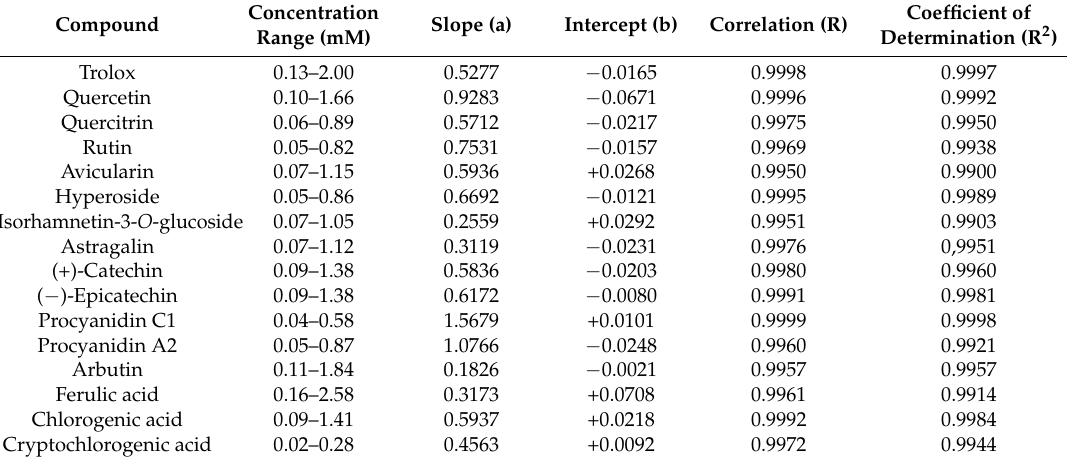
Table 4. Calibration curves (y = ax + b) data obtained by ferric reducing antioxidant power (FRAP) assay for tested